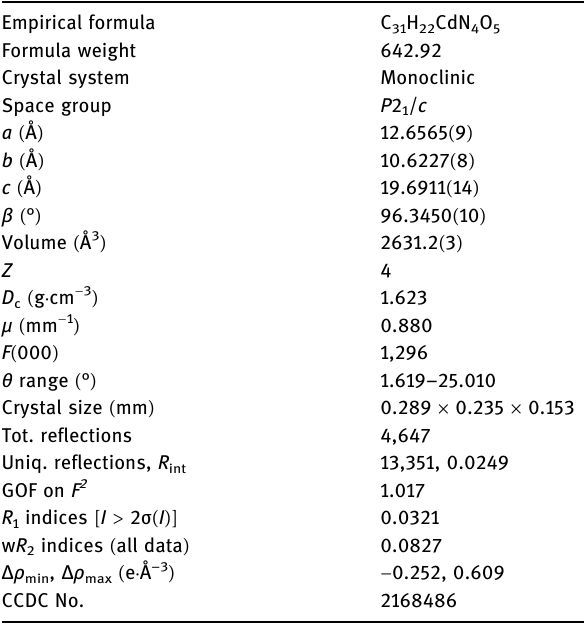
Table 2: Crystalline data and re fi nement parameters for complex 1 Empirical formula